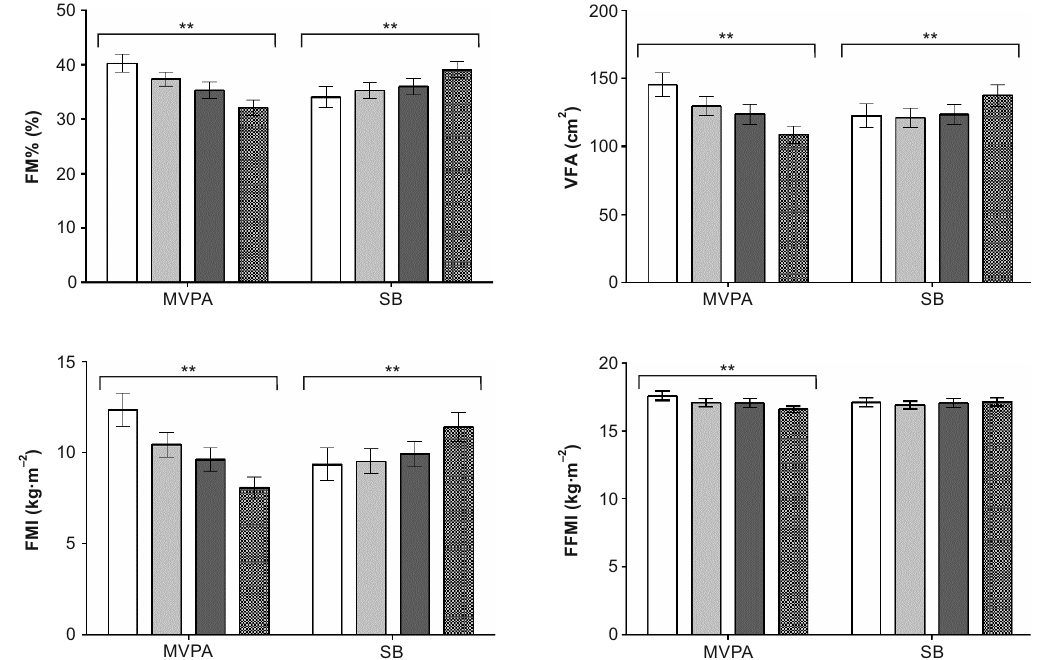
Figure 1. Differences in adiposity indicators and FFMI between differentially active and sedentary women. FM% = fat mass percentage; VFA = visceral fat area; FMI = fat mass index; FFMI = fat-free mass index; MVPA = moderate-to- vigorous physical activity; SB = sedentary behaviour. ** p <